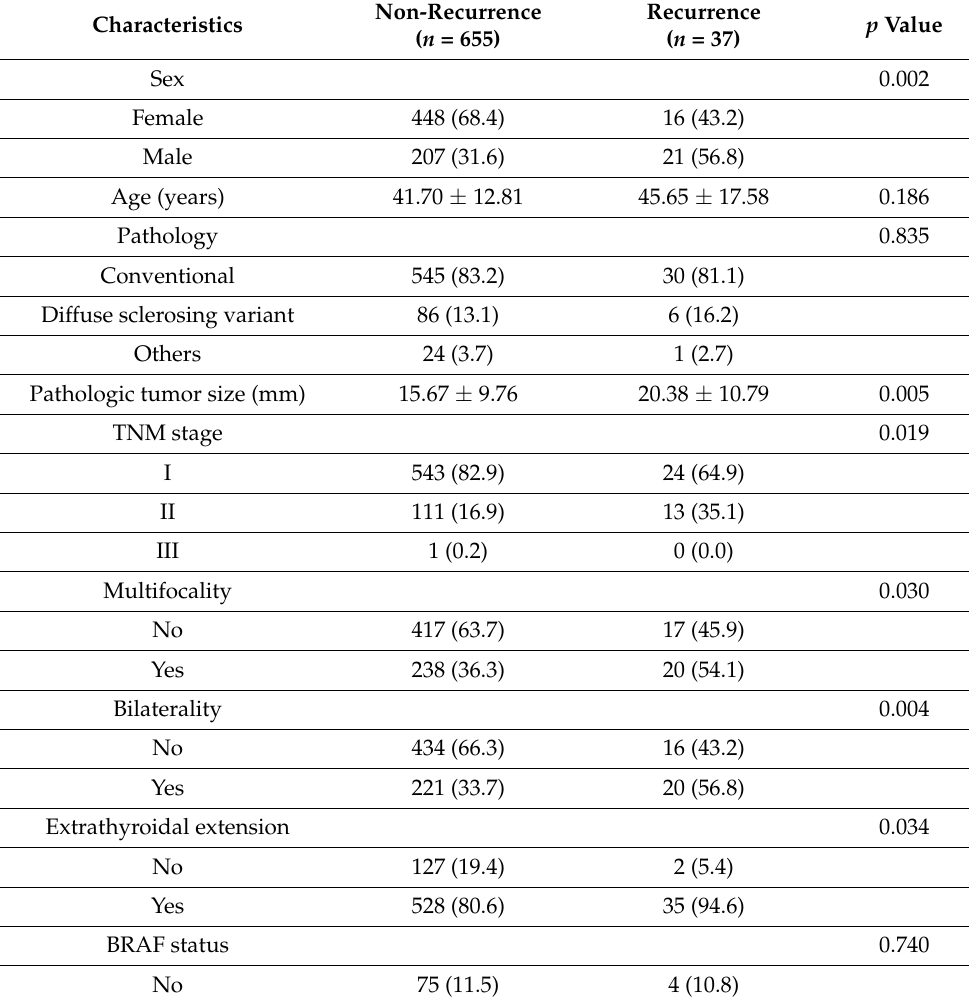
Table 1. Clinicopathologic characteristics of patients with N1b papillary thyroid carcinoma according to